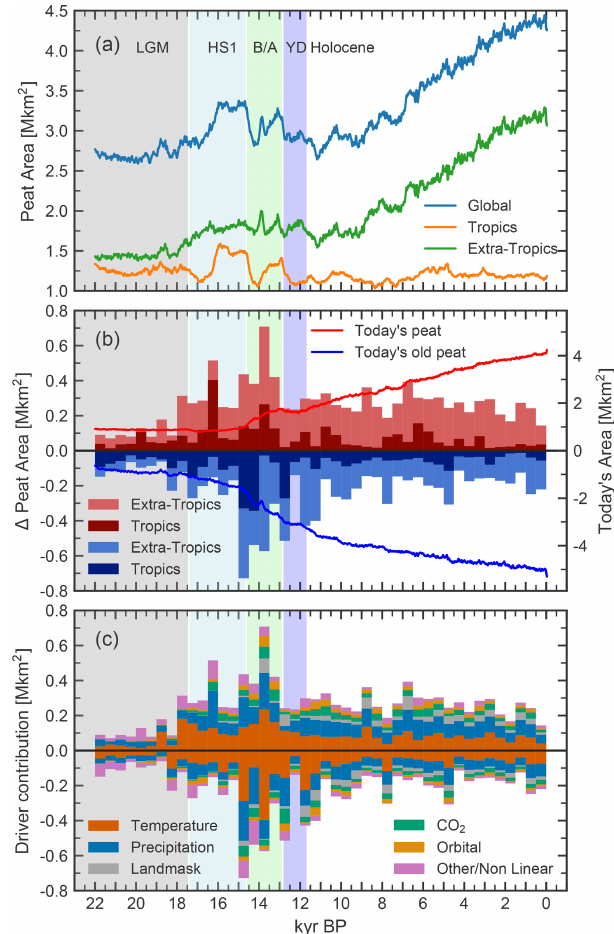
Figure 4. Simulated peatland area over time (a) , gross positive and negative peatland area changes in 0.5kyr bins, the evolution of to- day’s simulated peatland area and old peat area (b) , and driver con- tributions to the same changes (c) , calculated using factorial simu- lations (see Sect. 2.2). Contributions by regions (b) and by drivers (c) are plotted cumulatively. Vertical bars indicate the Last Glacial Maximum (LGM) period, the Heinrich Stadial 1 (HS1) Northern Hemisphere cold phase, the Bølling–Allerød (BA) Northern Hemi- sphere warm phase, and the Younger Dryas (YD) Northern Hemi- sphere cold